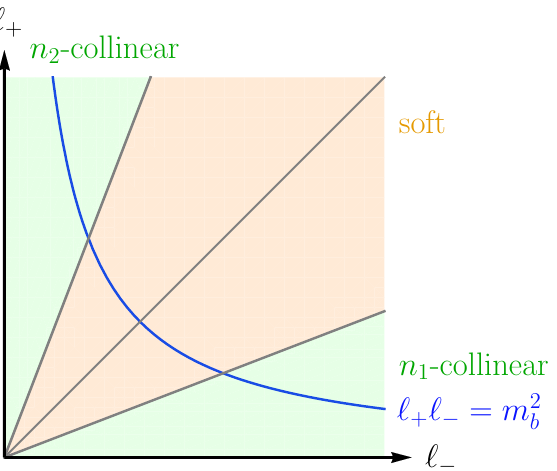
Figure 10 . Soft and collinear regions in the plane of the soft momenta ‘ (cid:0) and ‘ + . Contours of Figure 1: Soft and collinear regions in the ` ` + plane. Contour of constant ` + ` are hyperbolas    constant ‘ + ‘ (cid:0) are hyperbolas, as indicated by the blue line. The separation of the three regions in this plane. The separation of the three regions must be regularized using rapidity regulators. must be de(cid:12)ned using rapidity